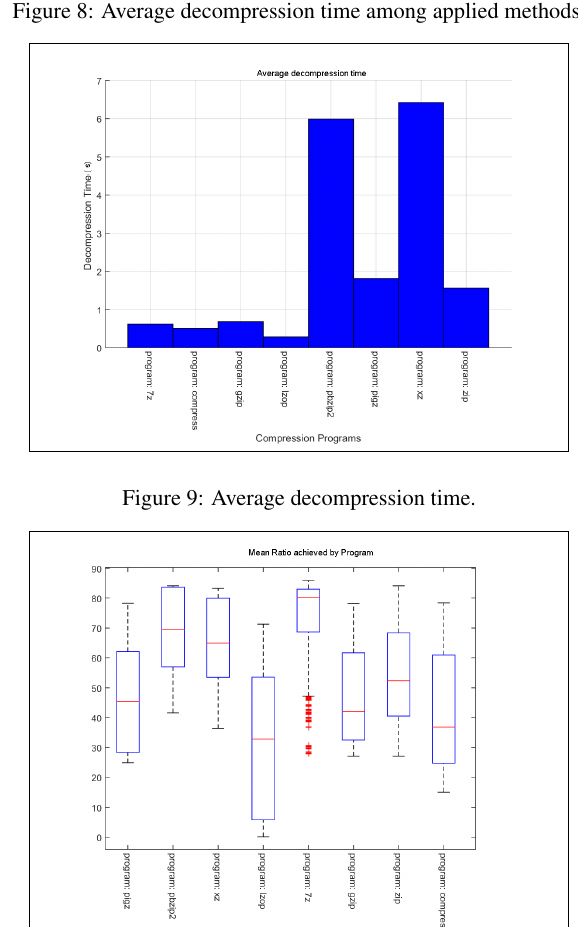
Figure 10: Box and whiskers plots showing statistics and achieved mean ratio per